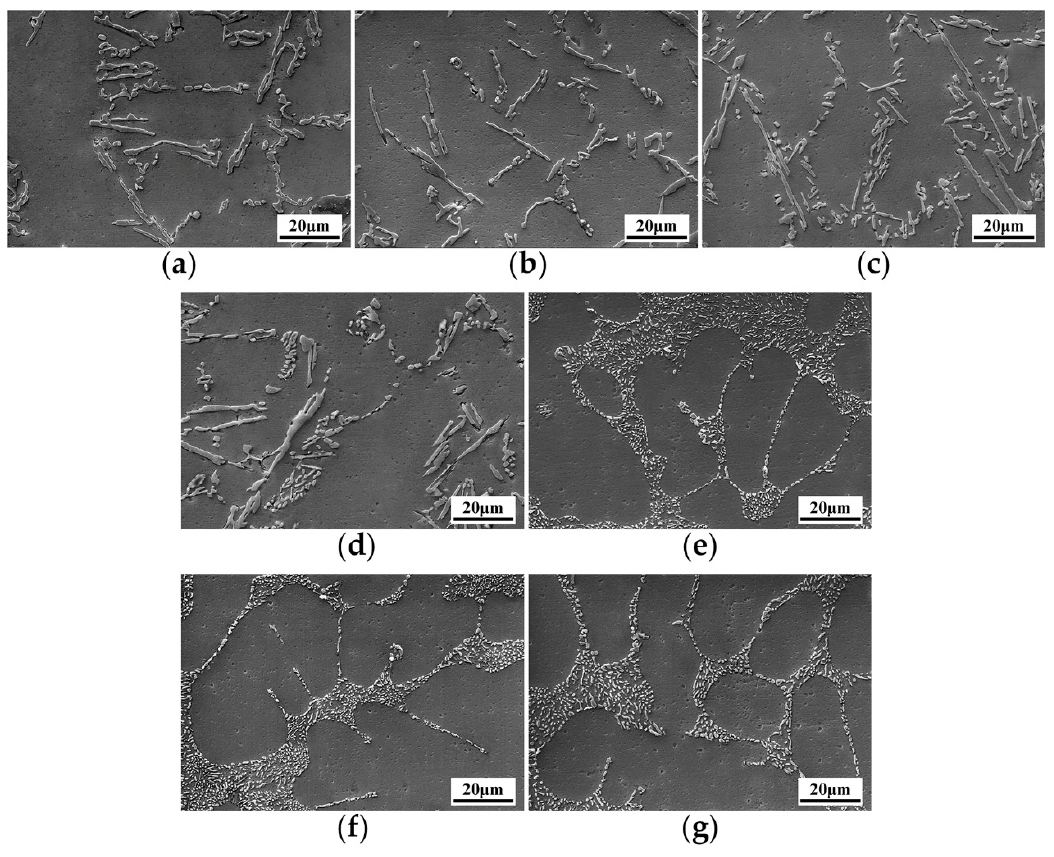
Figure 1. SEM microstructure of eutectic silicon in Al-8Si alloys with different contents of modifiers: ( a ) unmodified, ( b ) 0.1 wt.% Sb, ( c ) 0.3 wt.% Sb, ( d ) 0.5 wt.% Sb, ( e ) 0.04 wt.% Sr, ( f ) 0.08 wt.% Sr, ( g ) 0.12 wt.% Sr.